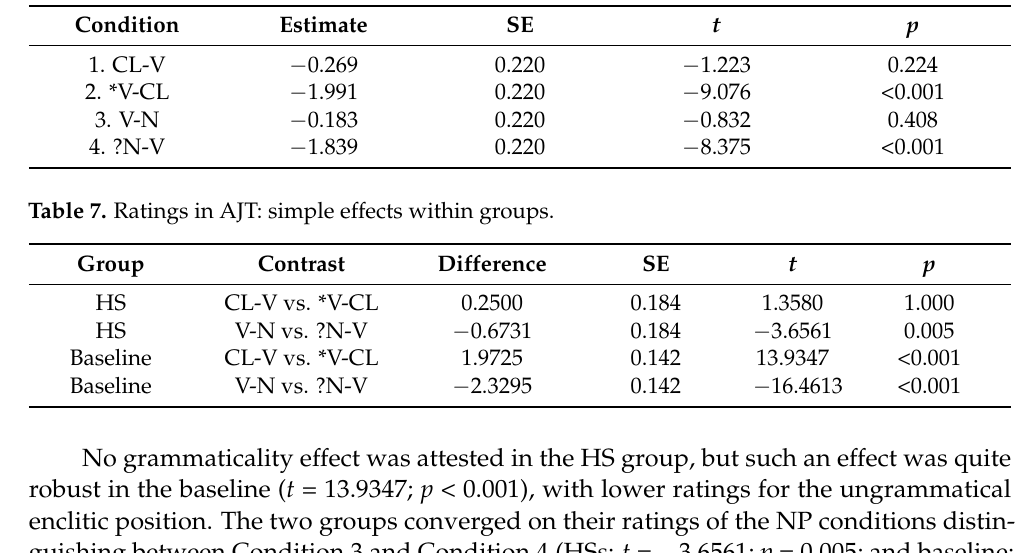
Table 6. Ratings in AJT: simple effects across groups.